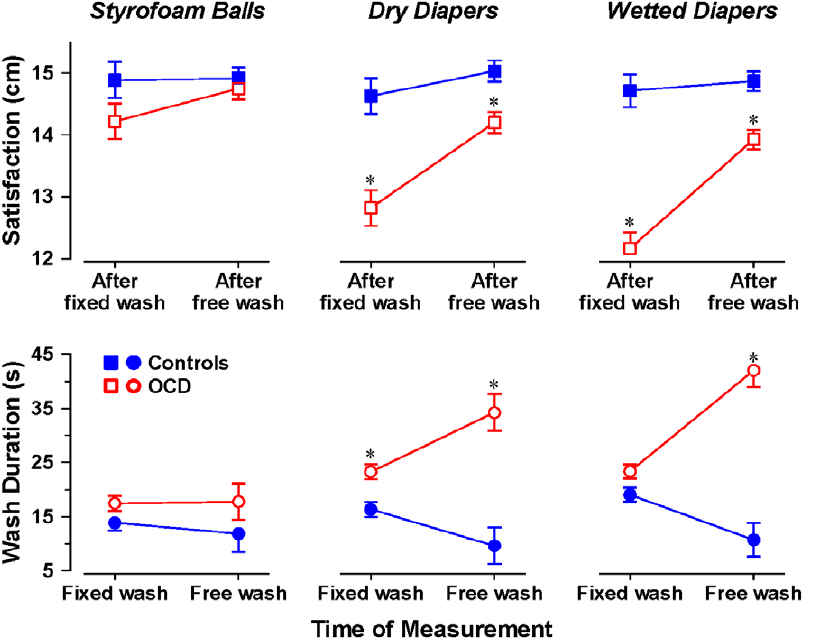
Figure 2. Effect of hand washing on satisfaction and wash duration in OCD patients with washing compulsions vs. non-patient controls. Note: * p , .05 vs. controls at the same time of measurement. Error bars represent 1 SE.